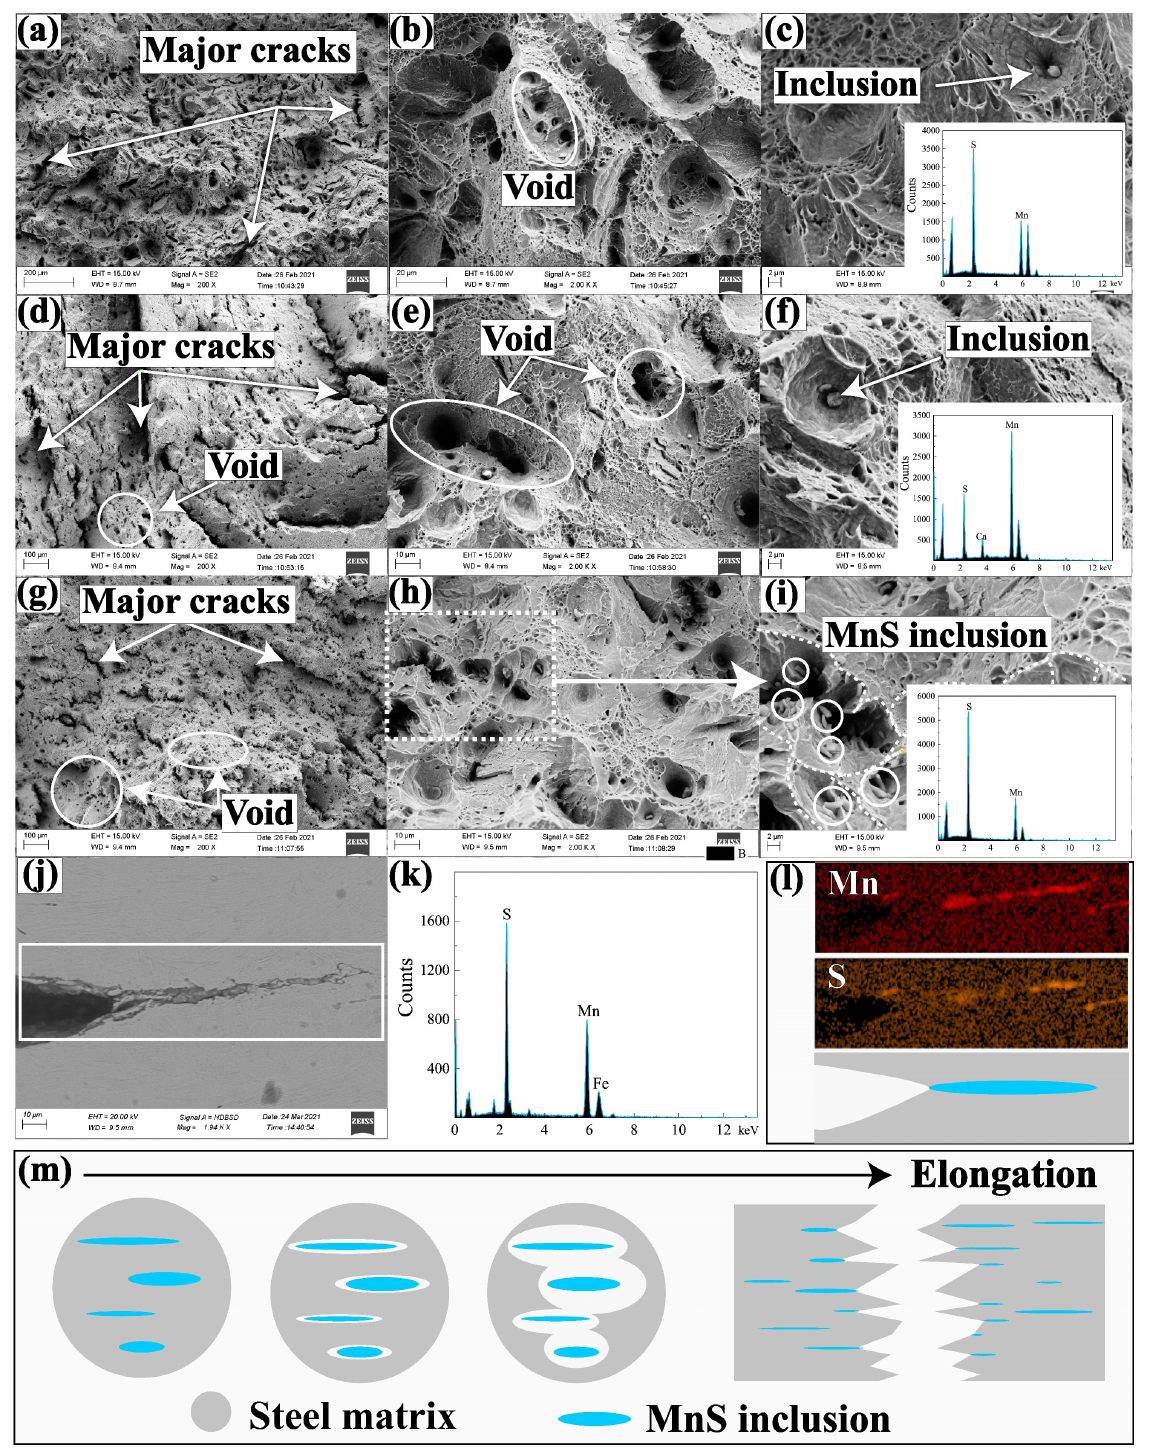
Figure 14. Morphology observation and inclusion analysis on tensile fracture. ( a – c ) tensile fracture of Steel A; ( d – f ) tensile fracture of Steel B; ( g – i ) tensile fracture of Steel C; ( j – l ) Longitudinal section of tensile fracture of Steel C; ( m ) Schematic diagram of MnS inclusion initiation fracture.